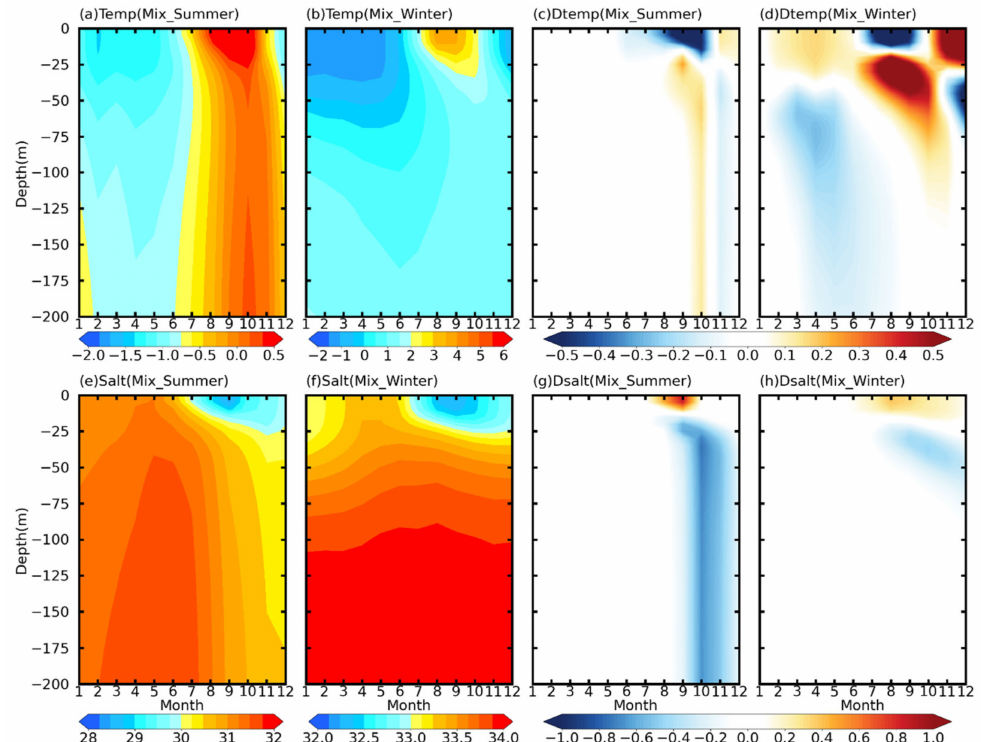
Figure 11. ( a , b ) indicates the temperature profile in the upper 200 m averaged over the Mix_Summer and Mix_Winter in the Ctrl experiment, respectively. ( c , d ) indicates the differences in temperature profile between Mix and Ctrl in the upper 200 m averaged over the Mix_Summer and Mix_Winter, respectively. ( e – h ) Same as ( a – d ), but for